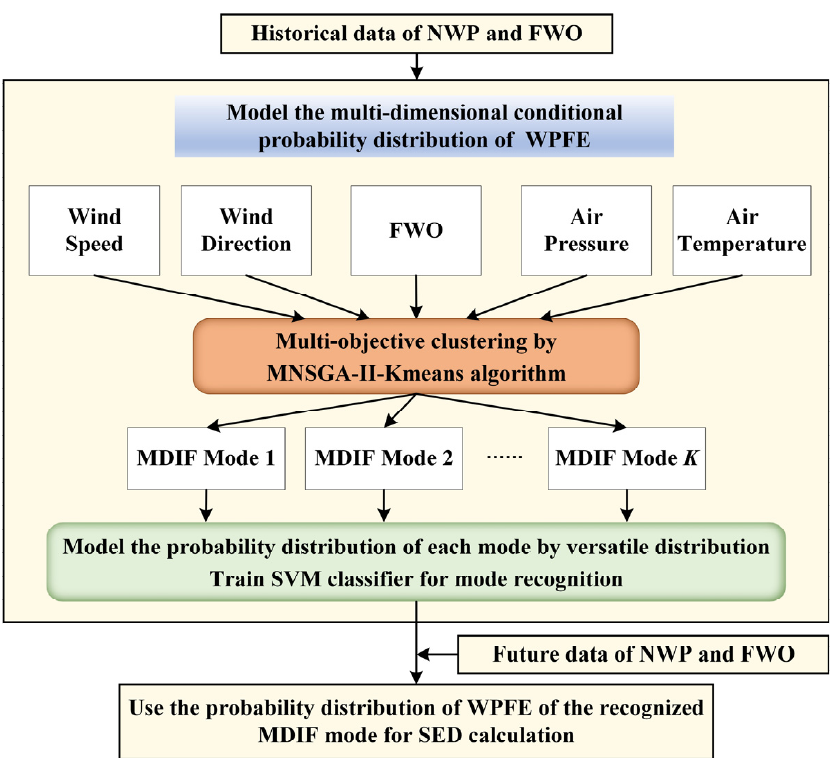
Figure 1. Idea of probability distribution modeling of multi-dimensional conditions for WPFE based on MNSGA-II-Kmeans.